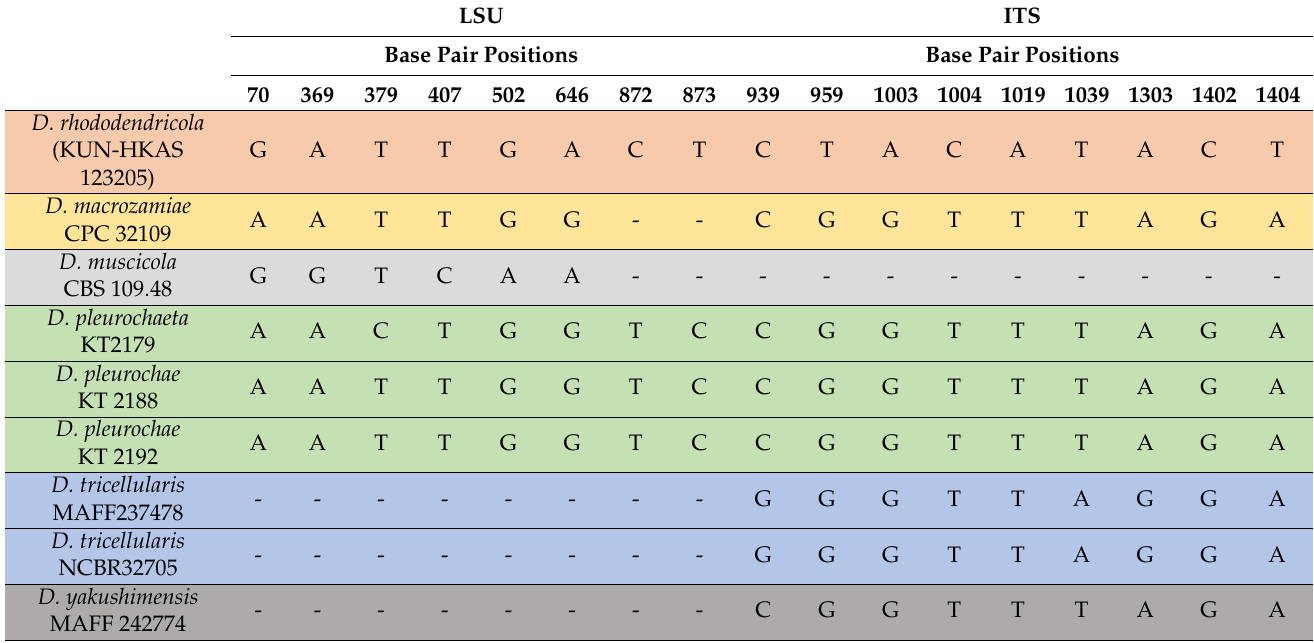
Table 4. LSU and ITS nucleotides comparisons of Discosia species related to our new taxon. LSU ITS Base Pair Positions Base Pair